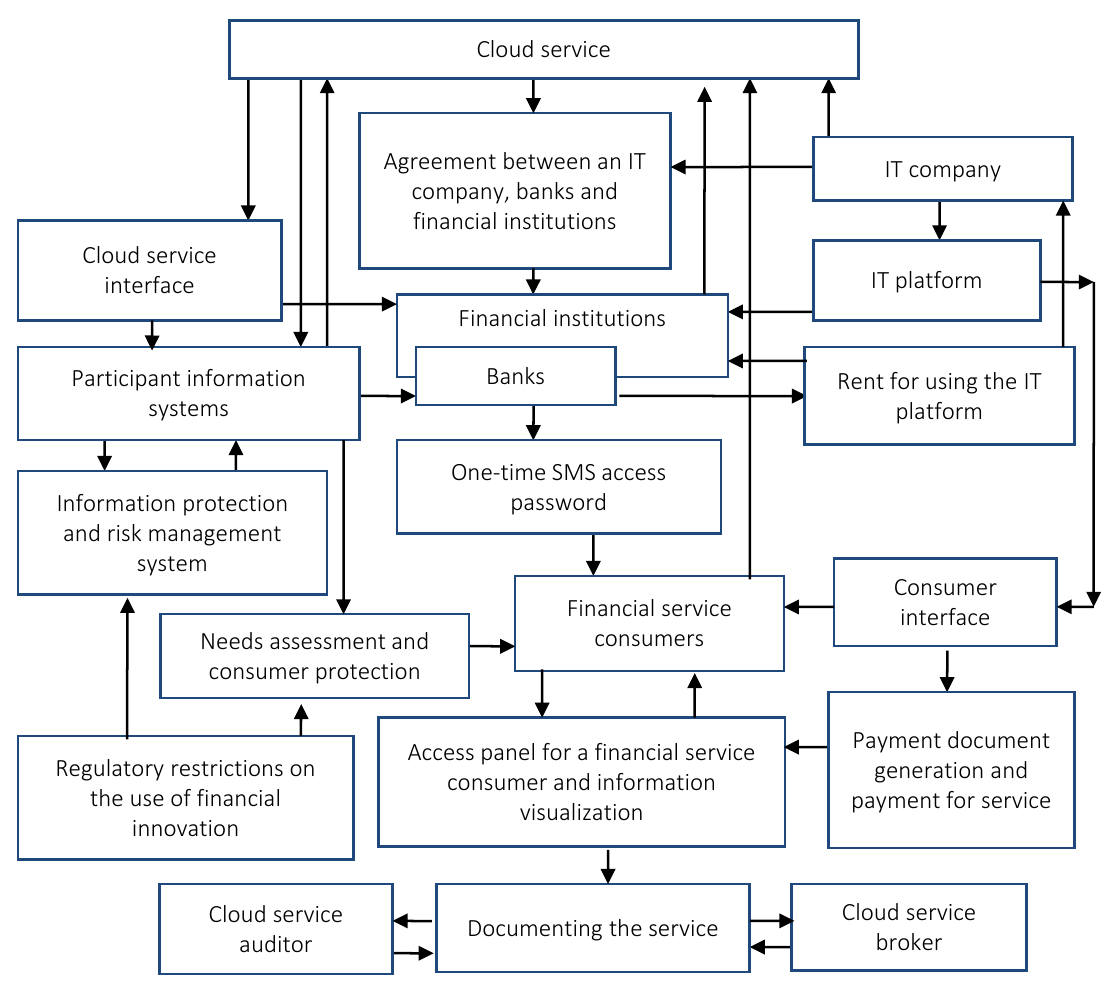
Figure 1. Organization of work on the provision of financial services using cloud service and blockchain